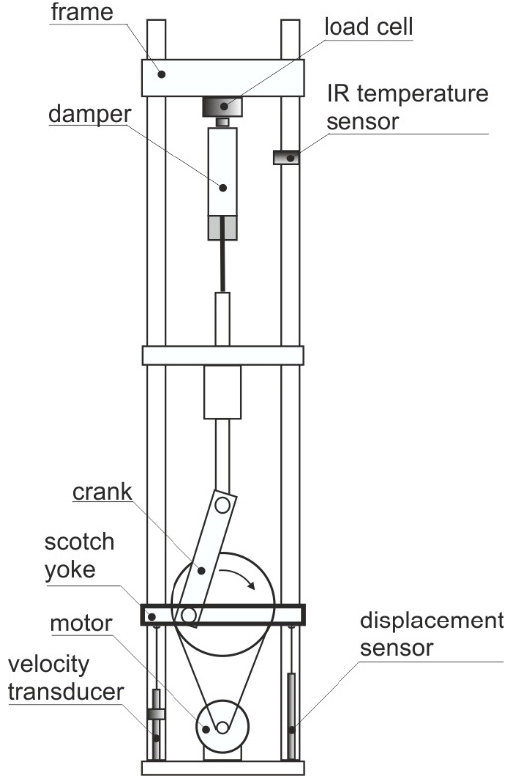
Figure 8. Scheme of a testing setup used for dampers characterization. Table 7. Measurement ranges in MR dampers